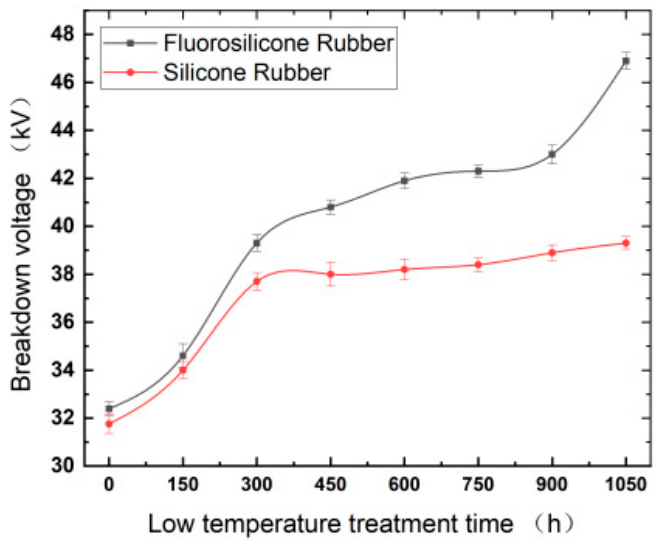
Figure 2. Variation of breakdown voltage with freezing time.